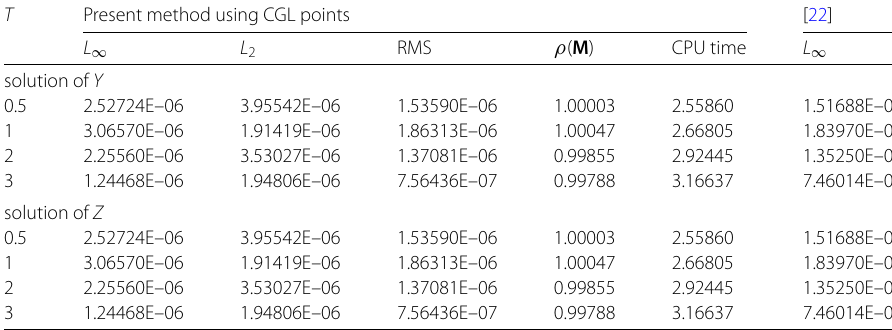
solution of Z 0.5